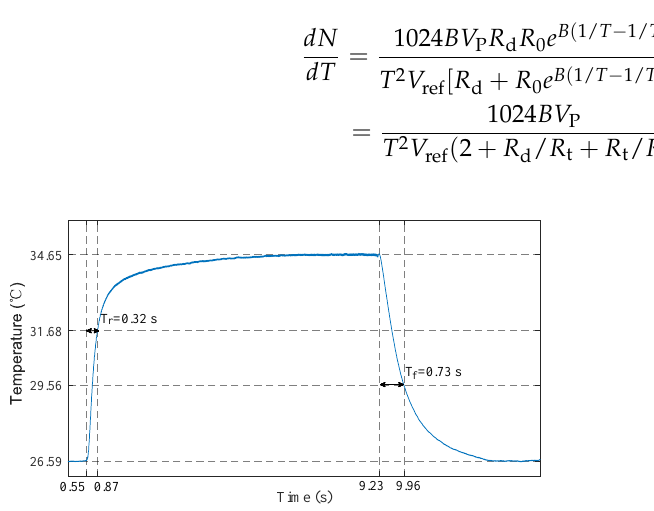
Figure 5. The step response of NTC temperature sensor, during which the sensor was heated with body temperature (finger) and cooled with ambient air.